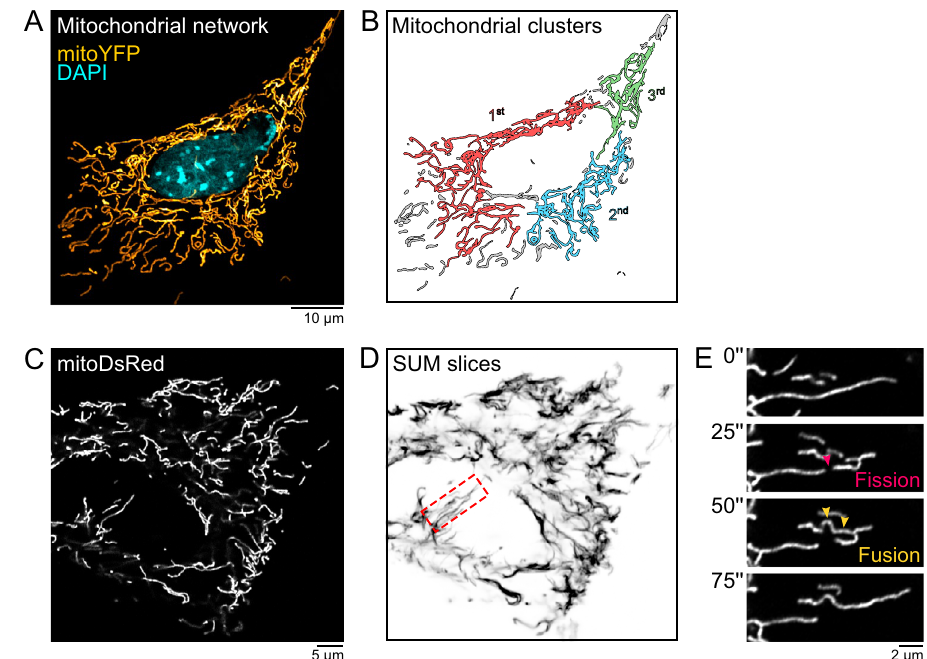
Figure 1. Mitochondrial network structure and dynamics. ( A ) Mitochondrial network of a mouse embryonic fibroblast (MEF) expressing a mitochondria-targeted yellow fluorescent protein (mitoYFP). ( B ) Segmentation and identification of the most relevant clusters in the network shown in ( A ). ( C ) Live-imaging of a MEF expressing a mitochondria-targeted red fluorescent protein (mitoDSRed). ( D ) Projection of different time frames revealing regions in the network with slow (dark) and fast (light) mitochondrial dynamics. ( E ) Zoom-in of the inset in ( D ) highlighting specific fission and fusion events occurring in the